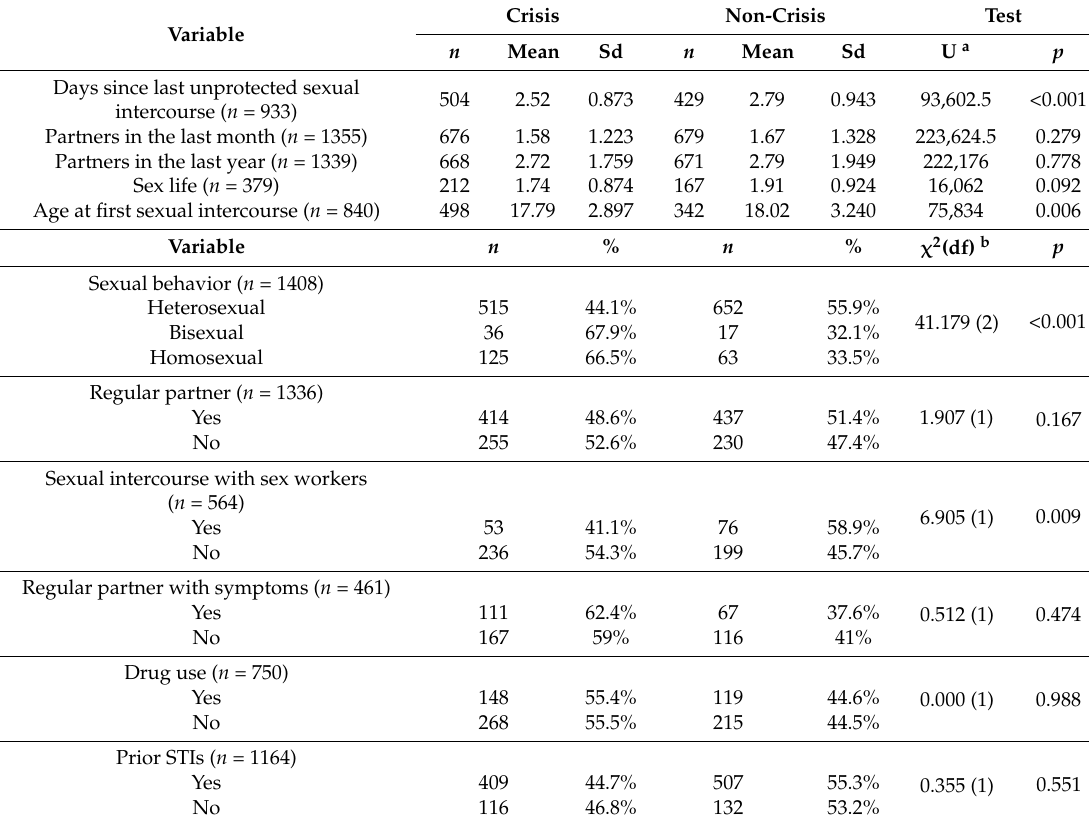
Table 3. Risk Indicators during the Crisis vs. Non-cCisis